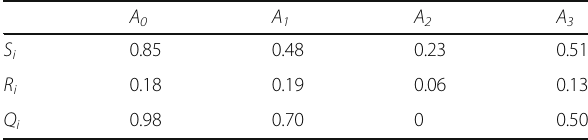
Table 7 Values of S , R and Q for all alternatives